Question: Based on the figure, does the quantity rise or fall?
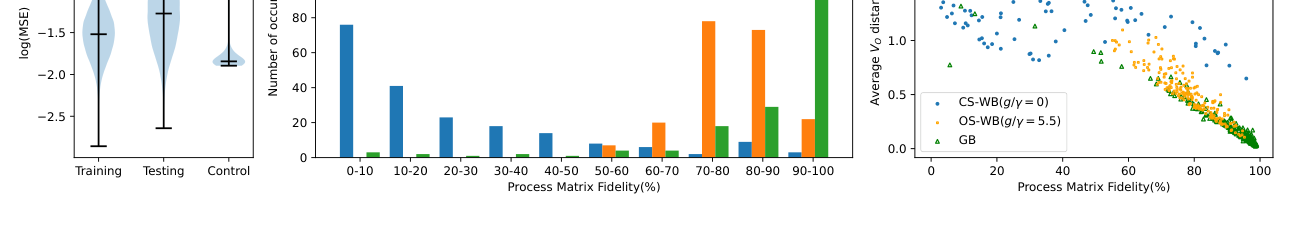
Answer: increasing